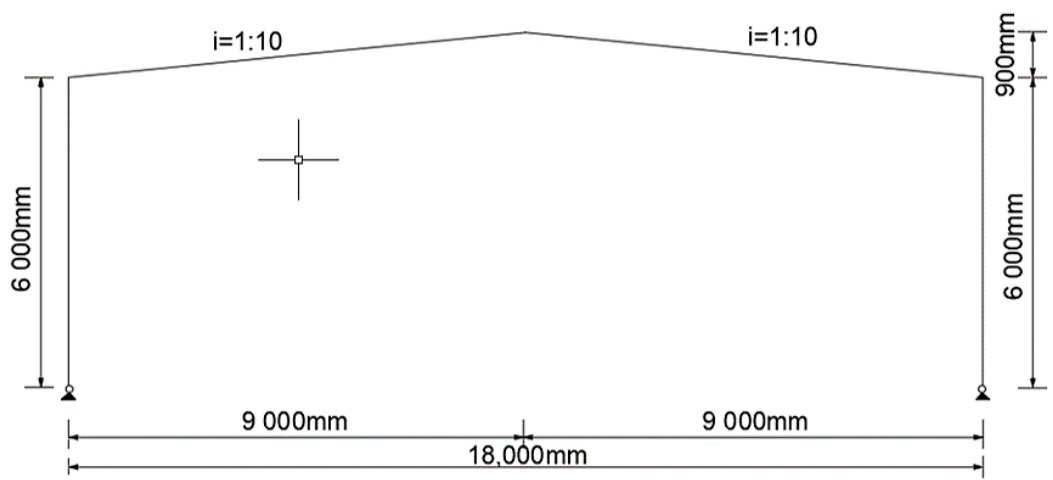
Figure 5. Form of the rigid frame.